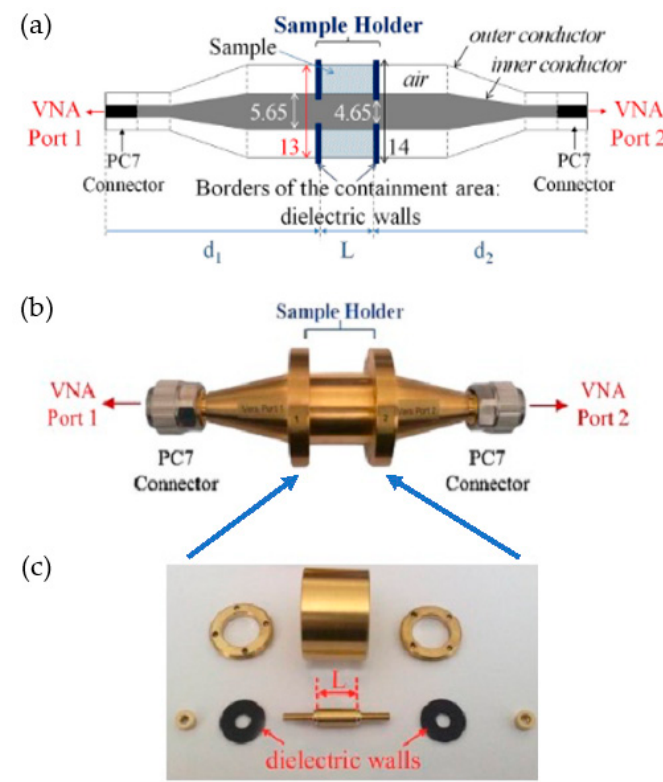
Figure 1. ( a ) Schematic diagram of the coaxial cell. ( b ) Photo of the fully assembled coaxial cell. ( c ) Dismantled coaxial cell. ( c ) Dismantled coaxial